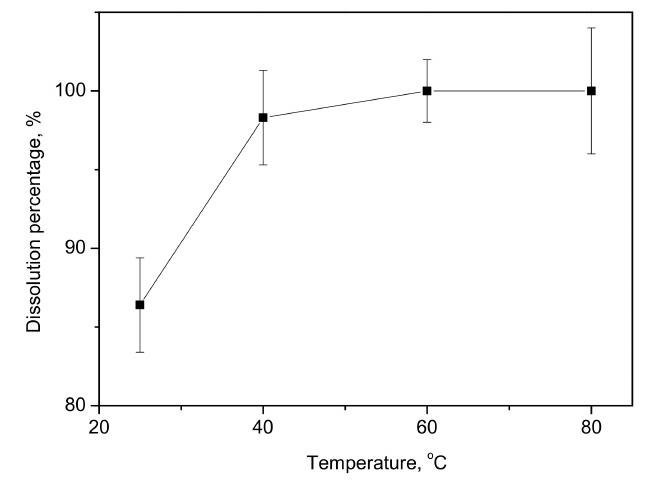
Figure 6. Effect of temperature on the dissolution of Pd. Conditions: TBP = 3 M; diluent: kerosene; Pd/HCl ratio = 12.5 g/L; Pd/H 2 O 2 ratio = 10 g/L; 60 min.